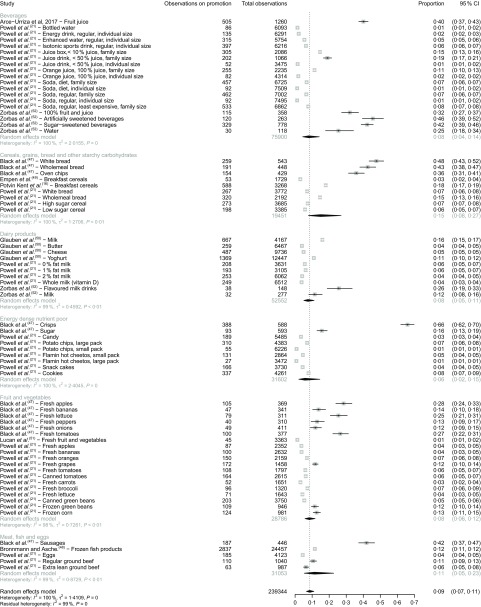
Forest plot of the prevalence of price promotions by food category